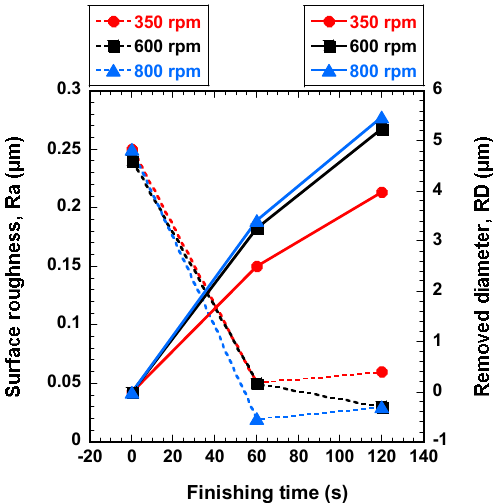
Figure 5. Effect of rotational speed of rotating magnetic field on surface roughness and the removed diameter (abrasive: 0.5 µm, 10 Hz).